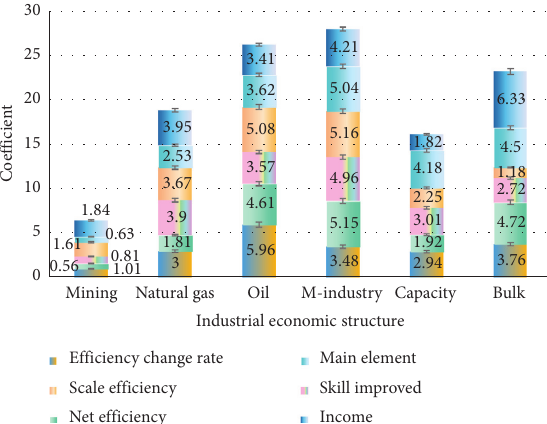
Figure 15: Results of the Malmquist index